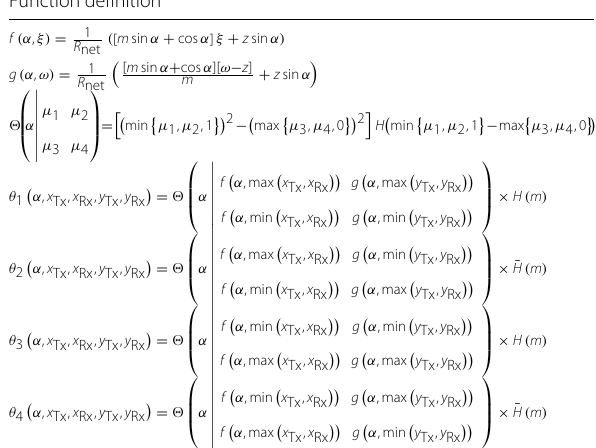
Table 2 Auxiliary functions used in Theorem 1 Function